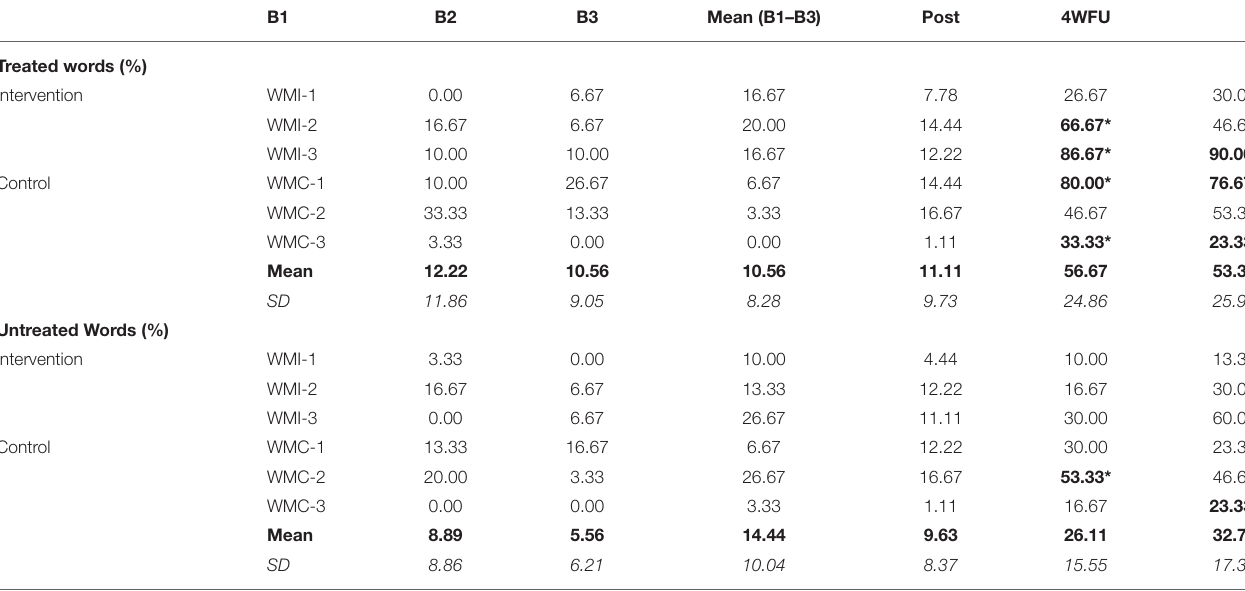
TABLE 2 | Percent naming accuracy of treated and untreated words for each individual participant, across the three baseline periods, and at post-treatment and follow-up. B1 B2 B3 Mean (B1–B3) Post 4WFU Treated words (%) Intervention WMI-1